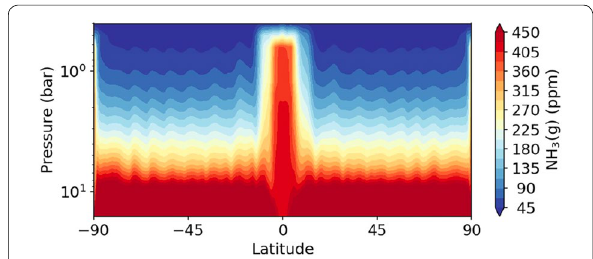
Fig. 8 A map in latitude and height (pressure) of the mass mixing ratio of NH 3 vapour obtained 100–200 days after tracers were injected into a Jason model simulation of Jupiter’s weather layer, without H 2 O latent heating and moist convection (Young et al.